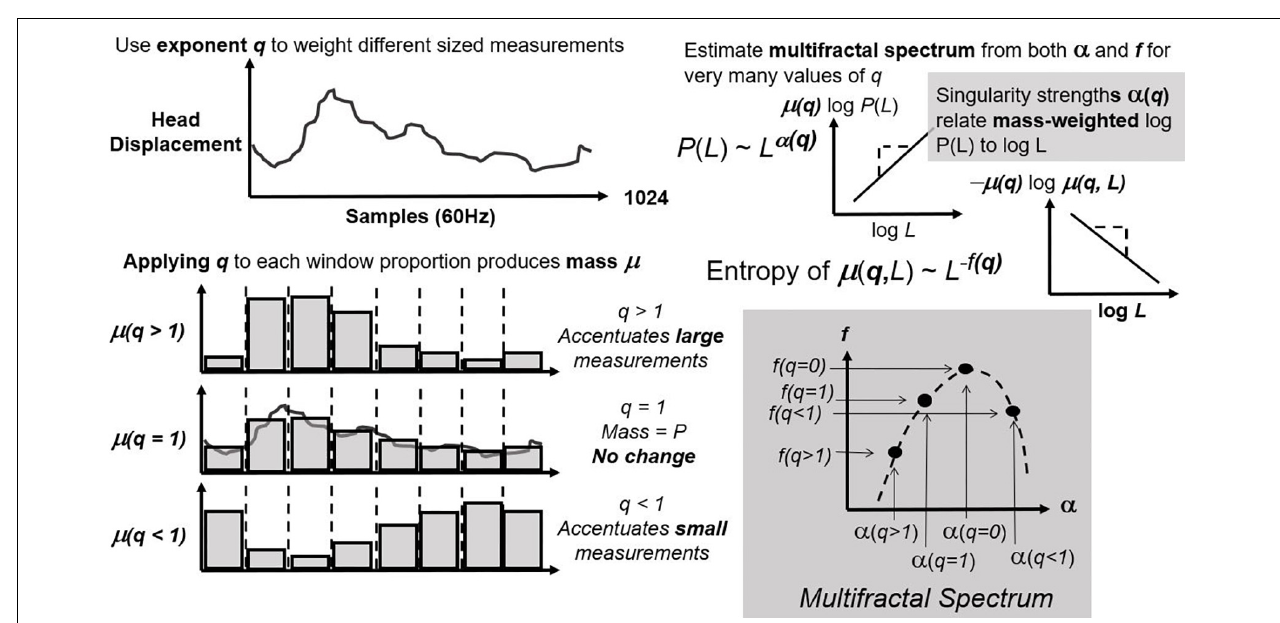
FIGURE 1 | Schematic of first steps of multifractal algorithm that bin a repeated measure on many scales (left panel) and that estimate linear relationships between logarithmic average proportion and bin size as well as between Shannon entropy and bin size.